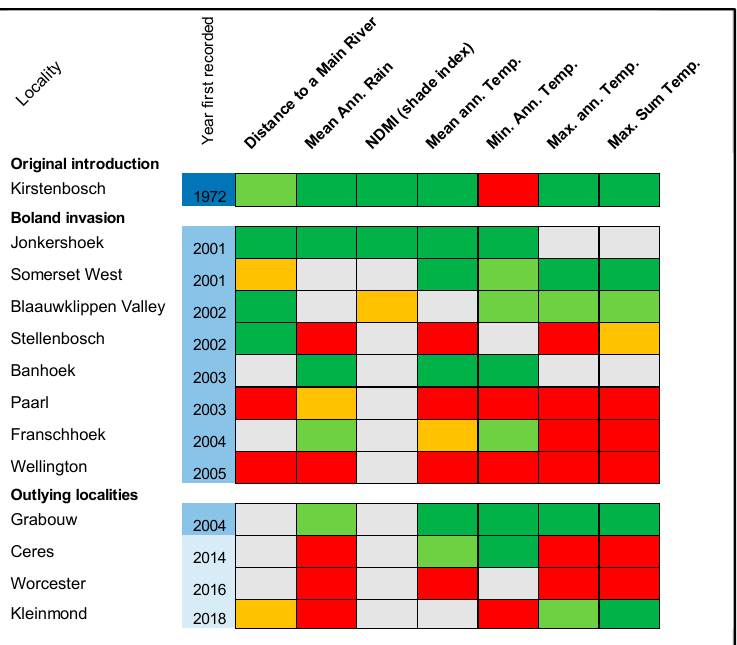
Figure 5. Matrix of spatial clustering (as quantified by Optimised Hot Spot Analysis) of environmental variables relative to localities where V. germanica has been recorded. Red blocks indicate significant clusters of unsuitable conditions (at the 99% confidence level; orange at 95%), while green blocks indicate significant clusters of suitable conditions (99% confidence level; light green at 95%), and grey blocks indicate non-significant clustering. [Localities not shown on maps: Kirstenbosch—area be- tween Cape Town and Wynberg; Somerset West—area North of Strand; Blaauwklippen Valley—area South of Stellenbosch; Banhoek—area North-east from Stellenbosch in the direction of